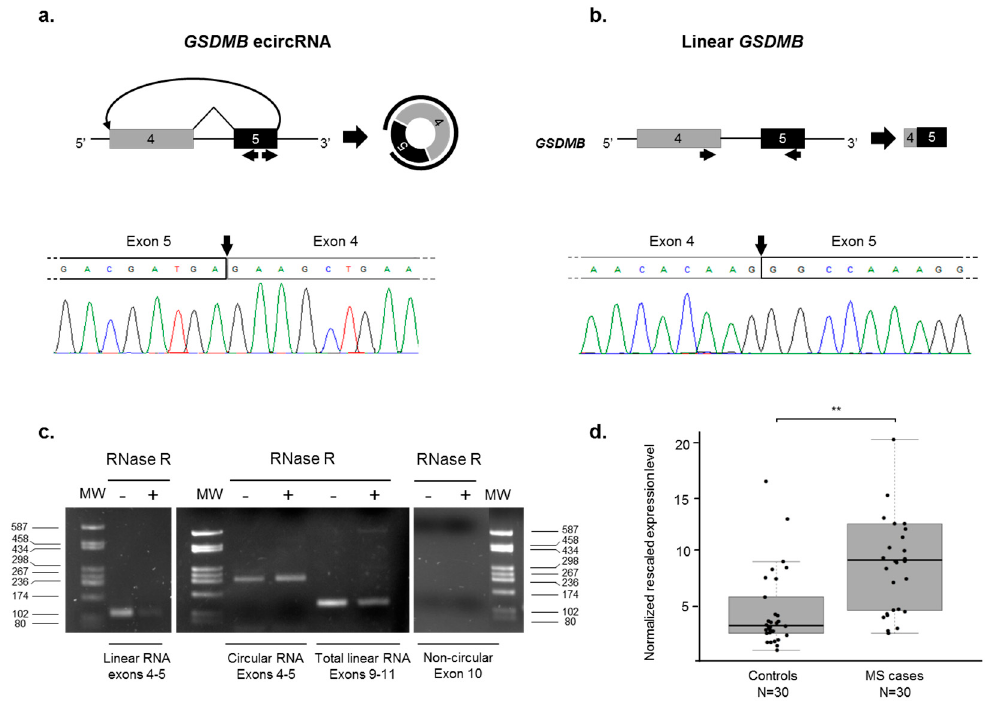
Figure 4. Characterization of the GSDMB exonic circular RNA (ecircRNA). ( a ) Schematic representation of the formation of the GSDMB ecircRNA through a backsplicing event between exons 4 and 5. Exons are approximately drawn to scale; exon 4 is depicted in grey, exon 5 in black. The curved arrow joins the 5 ′ splice site of exon 5 to 3 ′ splice site of exon 4. Arrows below exon 5 indicate the divergent primer couple used to detect the putative circular RNA (circRNA). On the right, a schematic representation of the circRNA is depicted, with the circular black line representing the product amplified by the primer couple. Below the scheme, direct-sequencing electropherograms show the head-to-tail splice junction, indicated by an arrow, located between GSDMB exons 5 and 4; ( b ) Schematic representation of the linear splicing involving exons 4–5. Arrows below exons 4–5 indicate the primer couple used in RT-PCR assays. Electropherograms showing the junction between exons 4 and 5 is also reported; ( c ) Agarose gel (2%) with the results of the RNase R treatment. The expression of the GSDMB ecircRNA was evaluated by RT-PCR in untreated ( − ) or RNase R-treated (+) RNA of a healthy control, using the divergent primer couple within exon 5. Expression of total GSDMB linear mRNA was also evaluated, using the RT-PCR assay shown in Figure 2 (linear product; exons 9–11), the assay reported in ( b ) (linear product; exons 4 and 5), as well as an assay using a divergent primer couple on exon 10 (negative control; no circRNA detected). MW: molecular-weight marker (pUC9- Hae III); ( d ) Boxplots show expression levels of the GSDMB ecircRNA measured by semi-quantitative real-time RT-PCR in PBMCs of 30 MS cases and 30 healthy controls. Boxes define the interquartile range; the thick line refers to the median. Results were normalized to expression levels of the HMBS housekeeping gene. The number of subjects belonging to each group is also indicated (N). The significance level of t -test analysis is shown. ** p < 0.01.